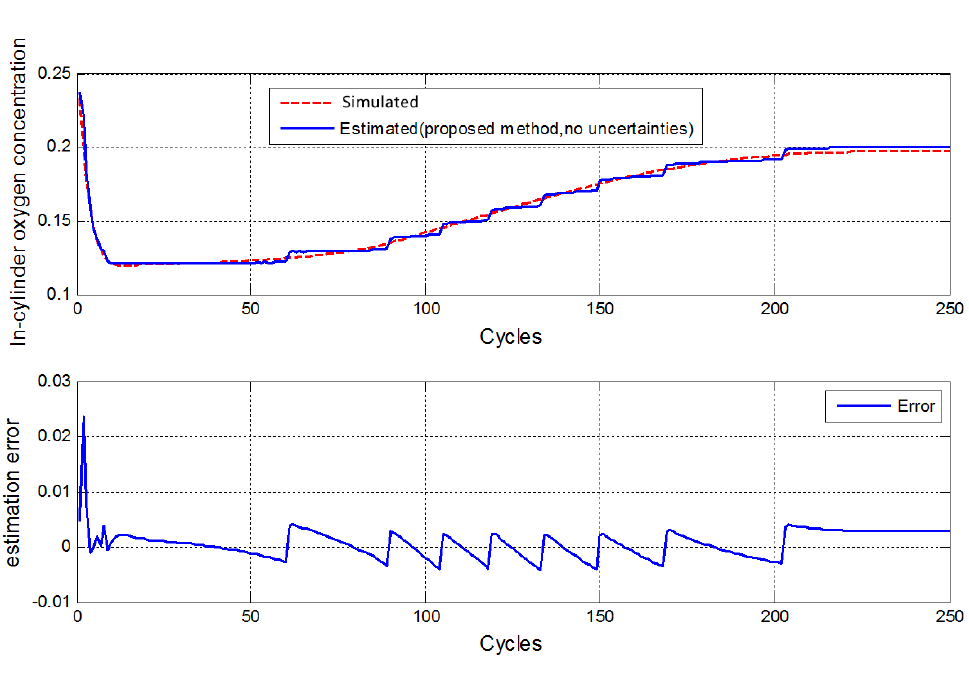
Figure 10. Performance of the virtual measurement (no uncertainties, 10% drift). Scenario II , with gas mass uncertainties and various ignition delay model